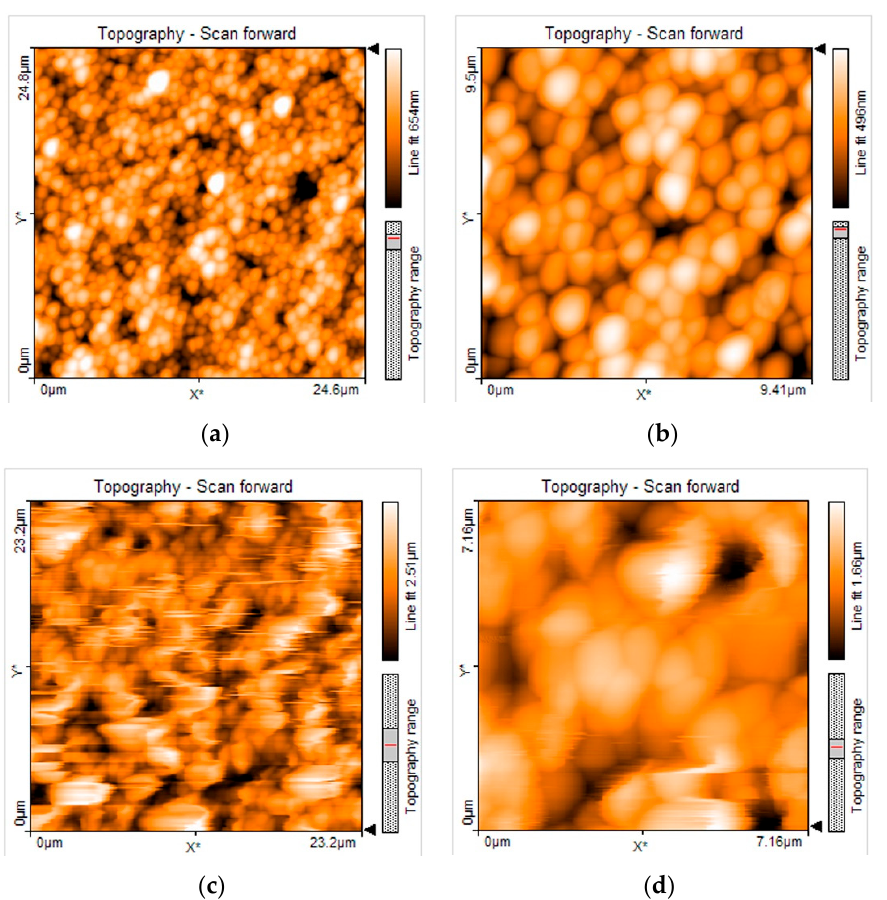
Figure 6. Antimicrobial analysis of serotype c of S. mutans strain by atomic force microscopy (AFM): ( a , b ) Control group; ( c,d ) AgNP 29.3 nm. To explore the action mechanism of AgNP, AFM analysis was carried out on bacterial cells of S. mutans exposed to AgNP. For bacterial cells non-treated with AgNP (control group) well-organized cells and non-altered cell morphology were identified ( a , b ). On the other hand, bacterial cells treated with AgNP ( c , d ) demonstrated to have more observable alterations in cell–cell adherence and more morphological alterations compared to non-treated bacterial cells. Even, bacterial cells exposed to AgNP could have had modifications to their cell membranes weakening the inner structure of their cell walls and producing relevant interferences in the position and scanning from the AFM tip, obtaining AFM images with considerable interference lines, and low evaluation quality.